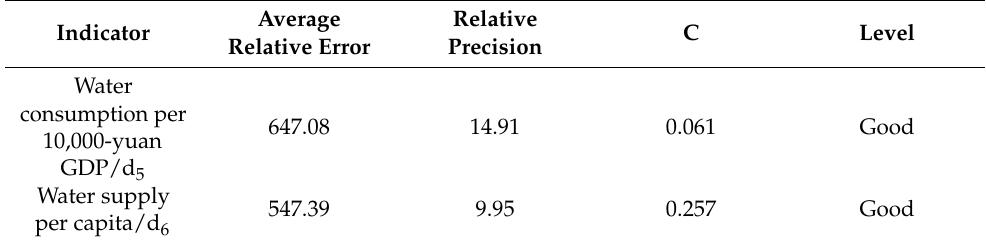
Table 2. Predicted results of precipitation in Beijing in 2020.